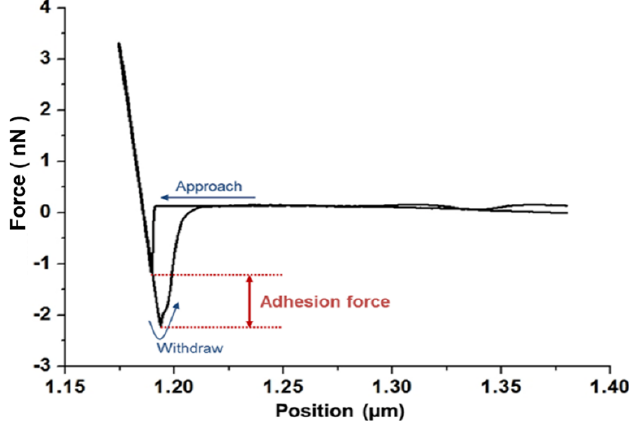
Figure 1. Force-distance curve of